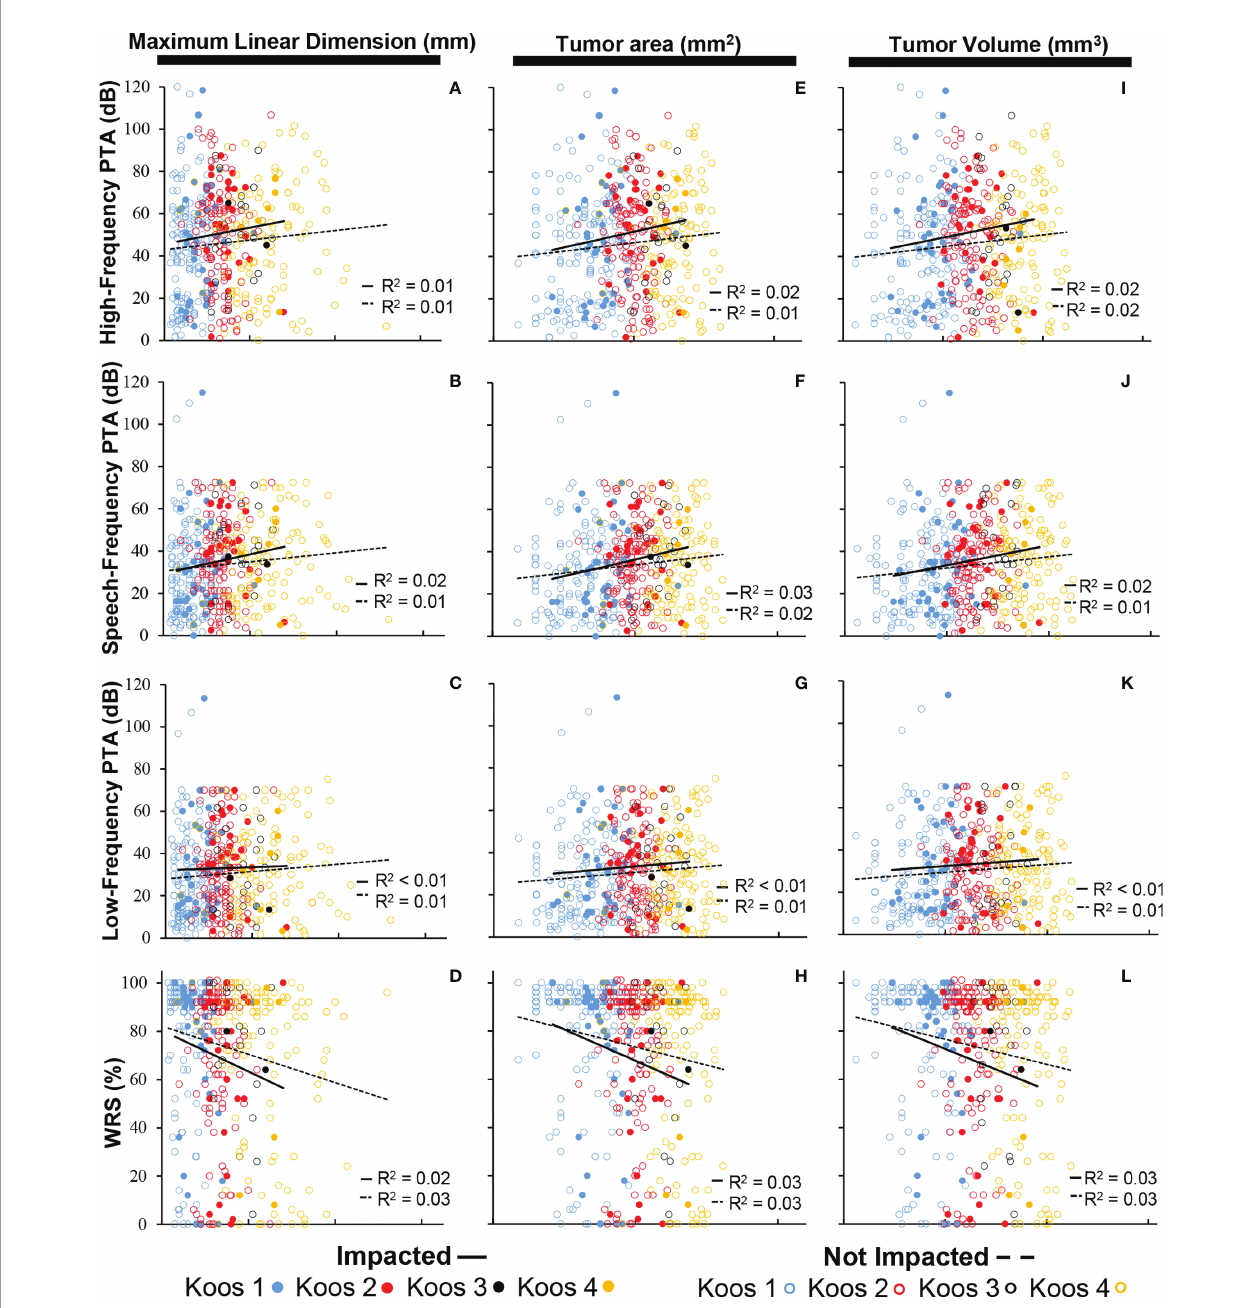
FIGURE 4 | Composite scatter plots showing the relationship in impacted and non-impacted groups between maximum linear dimension and PTA ( N = 477) calculated as (A) high-frequency PTA, (B) speech-frequency PTA, and (C) low-frequency PTA; (D) maximum linear dimension and WRS ( N = 461); cross- sectional area and PTA ( N = 477) calculated as (E) high-frequency PTA, (F) speech-frequency PTA, and (G) low-frequency PTA; (H) cross-sectional area and WRS ( N = 461); tumor volume and PTA ( N = 472) calculated as (I) high-frequency PTA, (J) speech-frequency PTA, and (K) low-frequency PTA; and (L) tumor volume and WRS ( N = 461). PTAs calculated in all three frequency ranges are not signi fi cantly associated with tumor size within both the impacted and non- impacted groups ( p > 0.05). WRS is not signi fi cantly associated with tumor size within both the impacted and non-impacted groups ( p > 0.05). PTA, pure tone average; WRS, word recognition